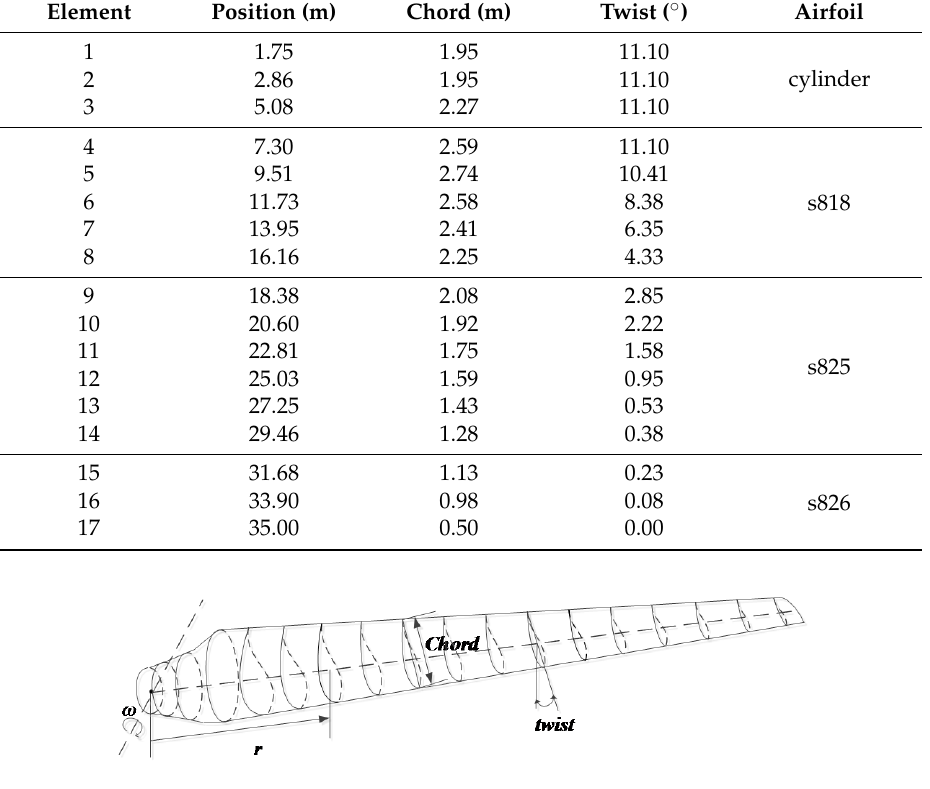
Figure 3. Geometrical description of the chord length and twist angle for the radial position. Table 2. Parameters for generating 3D turbulent wind.